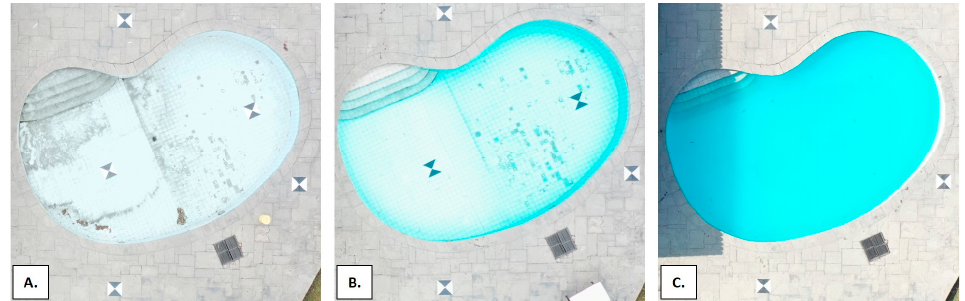
Figure 4. ( A ) Empty pool. ( B ) Pool filled with clean water. ( C ) Pool filled with copper sulfate.